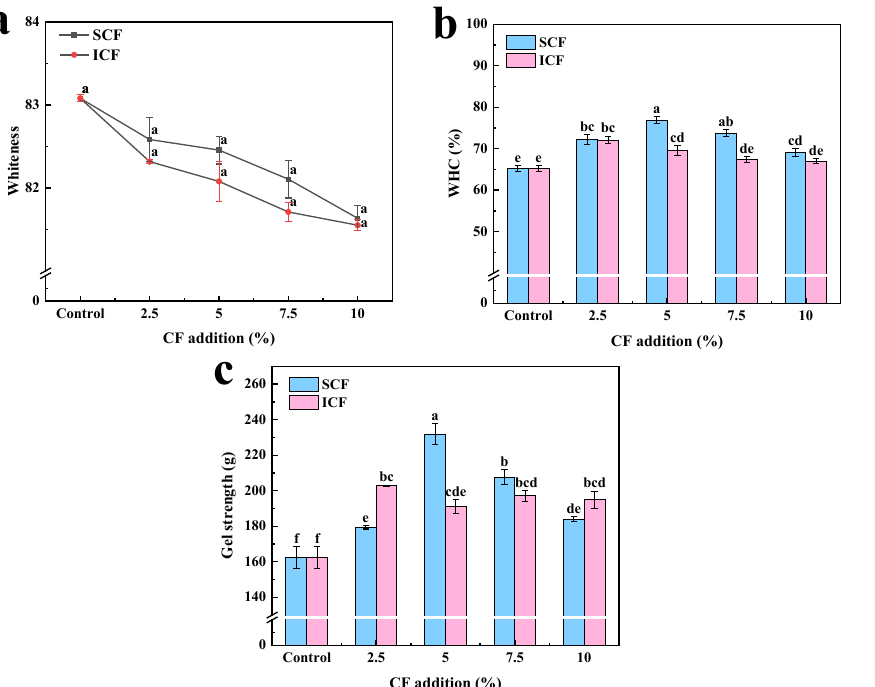
Figure 1. The whiteness ( a ), WHC ( b ), and gel strength ( c ) of the MP gels with different treatments. Each treatment was repeated at least in triplicate. Data are expressed as the mean ± SD. Different letters indicate significant differences ( p < 0.05).